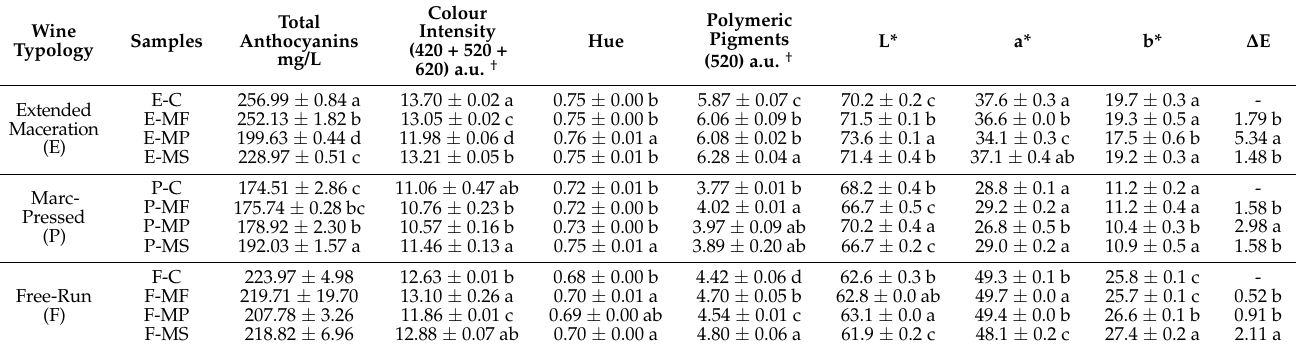
Table 1. The colour parameters of Sangiovese wines (E = extended maceration, P = marc-pressed, and F = free-run) aged on mannoproteins MF, MP, and MS for six